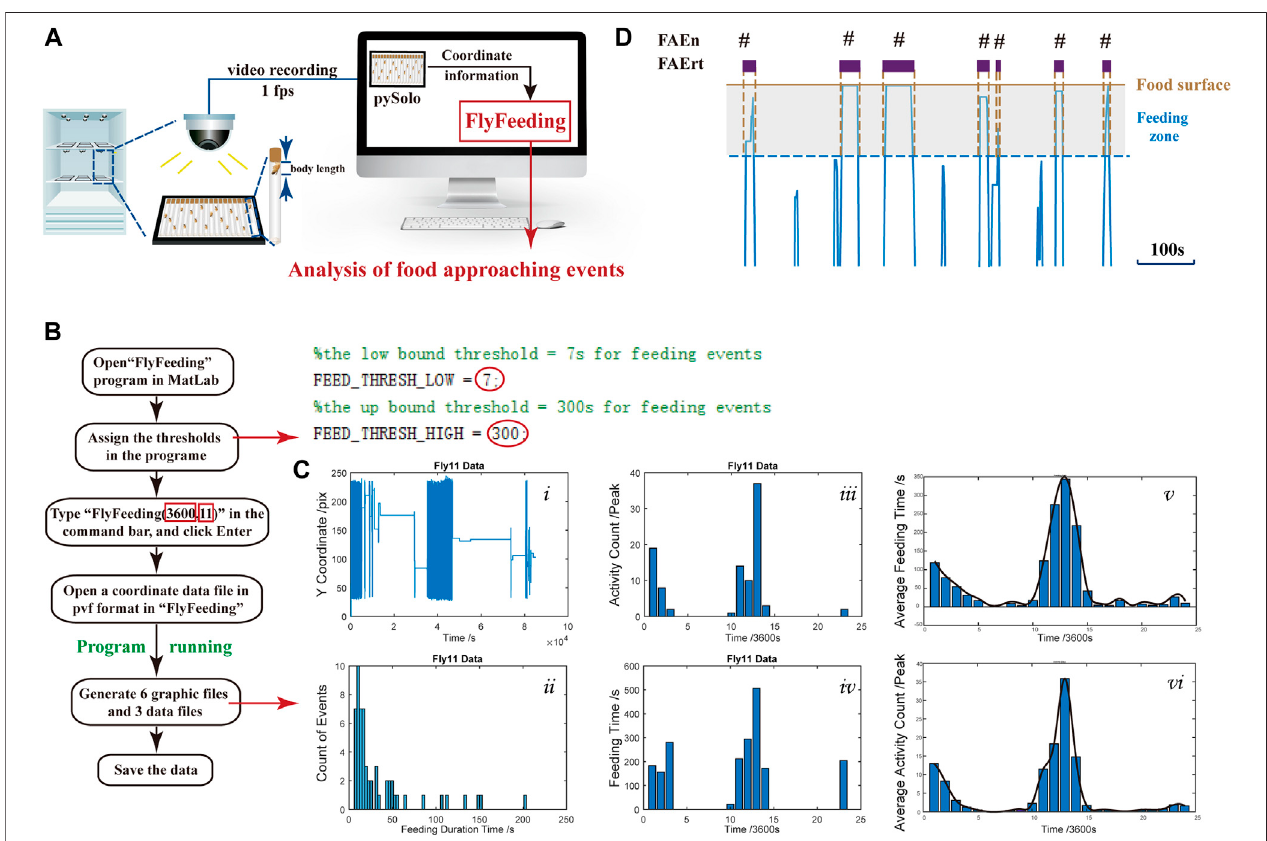
FIGURE 1 | Experimental setup, computer program, and data output (A) Experimental setup for dFRAME method. A group of 18 fl ies were monitored individually andthecoordinatedataareusedforanalysis (B) Operational fl owchartofthe “ FlyFeeding ” program.Therightpartrepresentsascreenshotoftheprogramstart;thecut- off thresholds can be assigned by users (red circles). The two numbers in red rectangles indicate the analyzing period (3,600 s) and fl y body length (11 mm) (C) “ FlyFeeding ” simultaneously analyzes a group of 18 fl ies, generating a set of six graphs and three data fl ies. Graphs i – iv show the analytical results of a representative fl y, including the movement tracks (i), the FAEn distribution according to either the residence time (ii) or in every hour of the day (iii), and the FAErt distribution in every hour of the day (iv). The averaged distribution of FAEn and FAErt of the 18 fl ies are shown in every hour of the day (v and vi, respectively). In addition, theprogramgenerates threedata fi les, “ Activity.csv ” forFAEneveryhour, “ Feeding.csv ” fortotal FAErteveryhour,and “ FeedingPDF.csv ” forFAErtofeach time.Alldata are listed for individual fl ies (D) Schematic diagram of food-approaching events (FAE). The brown line indicates the food surface. The gray area represents a fl y body lengthfromthefoodsurface,whichisdetermined asfeedingzone.Ashort periodofmovementtrackwasclipped out,andthoseclosetothefoodendareshowninblue lines. Once the fl y enters the zone, the FAEn counts 1, and the duration that the fl y stays in the zone is recorded as the